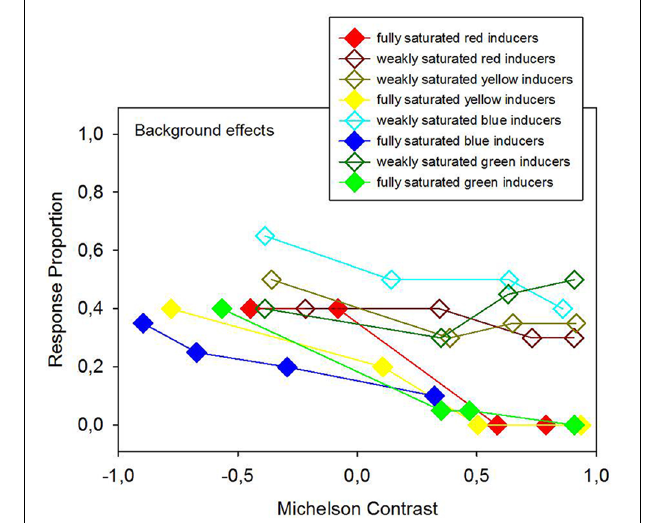
FIGURE 8 | Average response proportions of background effects, indicating that the colored inducers were seen as ground, as a function of hue, Michelson contrast, and saturation levels of the colored inducers. 2 × 2 ANOVA signaled a statistically significant effect of saturation (analysis 3) on background effects, where weakly saturated inducers produce stronger ground percepts than fully saturated inducers, as shown here in the